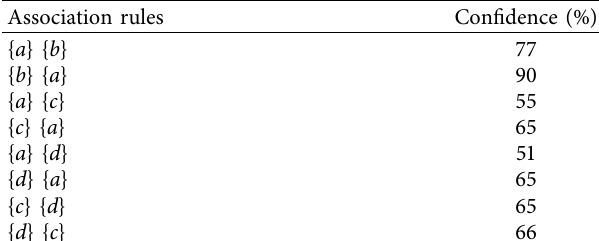
Table 3: All association